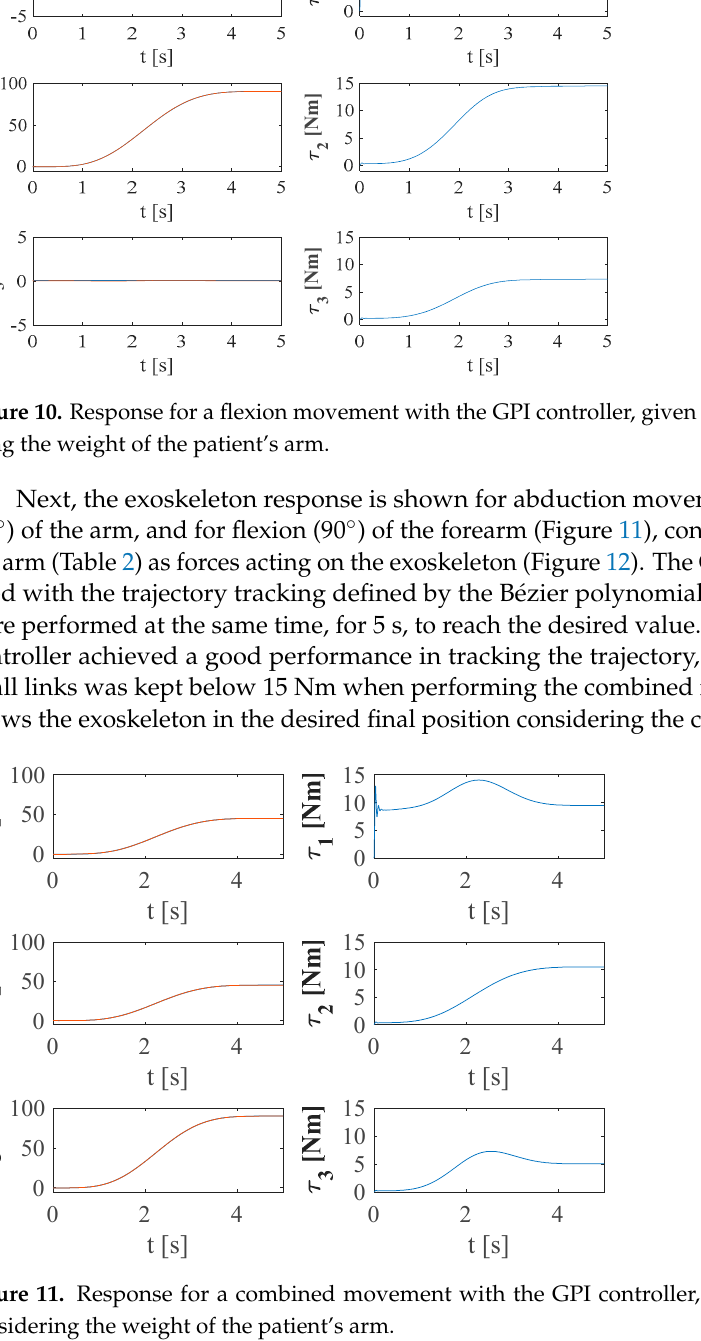
Figure 11. Response for a combined movement with the GPI controller, given by Equation (13), considering the weight of the patient’s arm.